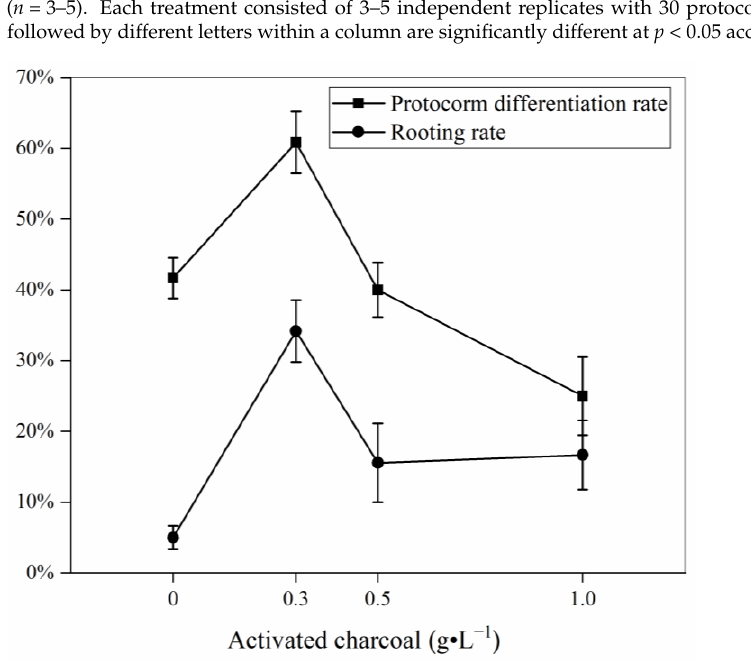
Figure 2. Effect of activated charcoal on protocorm differentiation of Paphiopedilum tigrinum . The basal medium was 1/4 MS medium supplemented with 1.0 mg · L − 1 Kin and 100 mL · L − 1 coconut water. Each treatment consisted of 3–5 independent replicates with 30 protocorms per replicate. Data are means ± SE ( n = 3–5). Different letters represent significant difference at p < 0.05 according to